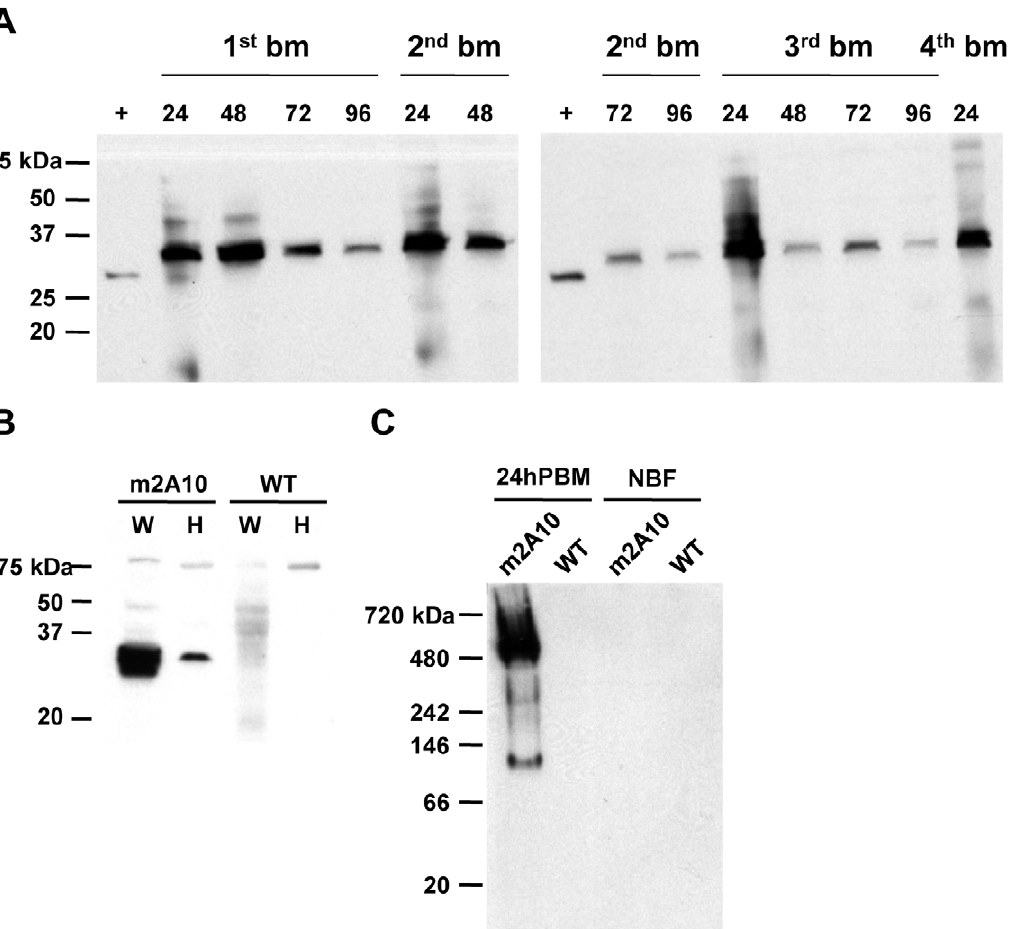
Figure 4. Bloodmeal-induced expression of m2A10 scFv. (A) Immunoblot analyses of transgenic m2A10 44.1 An. stephensi . An anti-E tag antibody was used to detect m2A10 protein in whole body homogenates of transgenic females. Purified m2A10 scFv protein, which contained an E tag but did not contain Cecropin A, was used as a positive control ( + ). Female mosquitoes were given bloodmeals (bm) once every five days, and examined at 24, 48, 72, and 96 hours after each meal. (B) An immunoblot of both whole females (W) and a hemolymph preparation of females (H) from transgenic m2A10 44.1 and wild-type control mosquitoes (WT) 48 hours post-bloodmeal. Anti-E tag antibody was used for detection of m2A10. (C) An immunoblot of m2A10 and wild-type control female hemolymph samples, prepared in non-denaturing conditions (left panel) and probed with anti-E tag antibody. Non-bloodfed (NBF) and 24 hours post-bloodmeal (24hPBM) females were compared. NativeMark protein standard (Invitrogen) was used for molecular weight estimation. Control images of the Coomassie-stained gels are provided in Figure